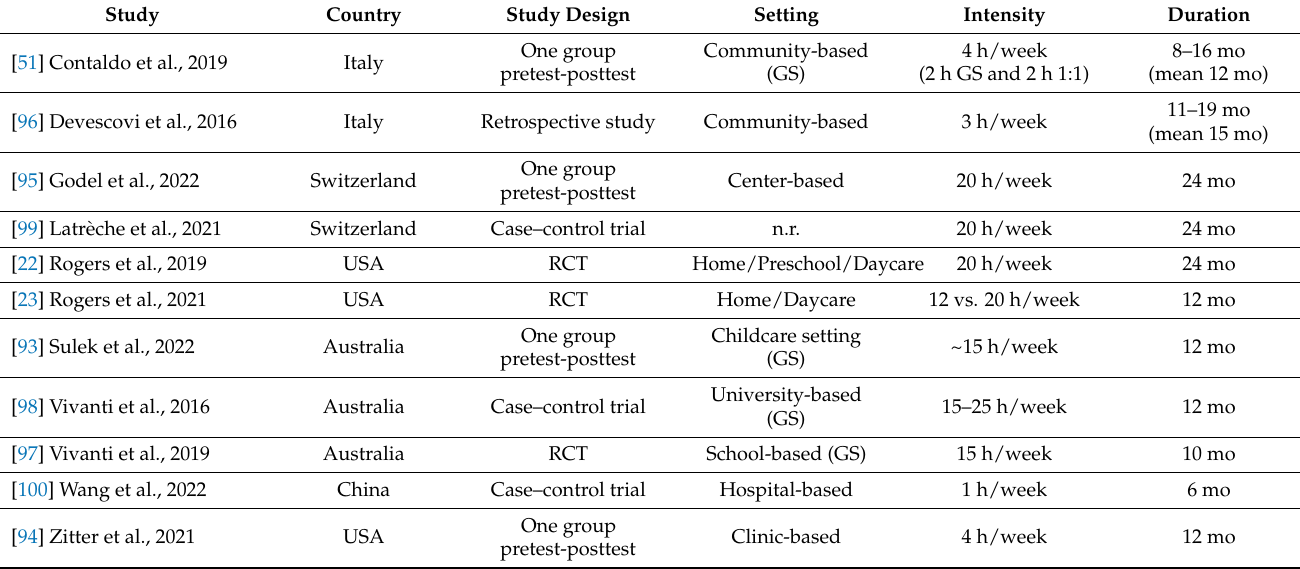
Table 5. Summary of ESDM studies: intervention